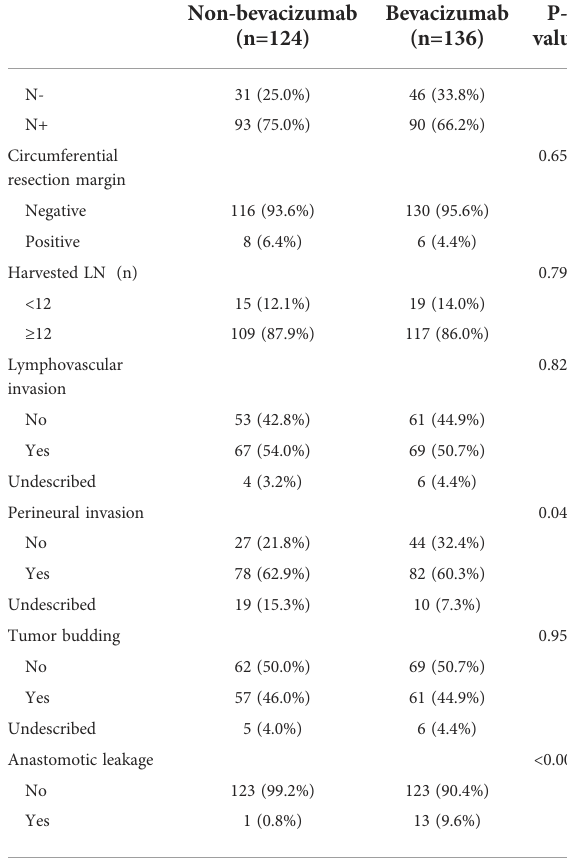
TABLE 1 Baseline clinicopathologic features of patients in the bevacizumab and non-bevacizumab